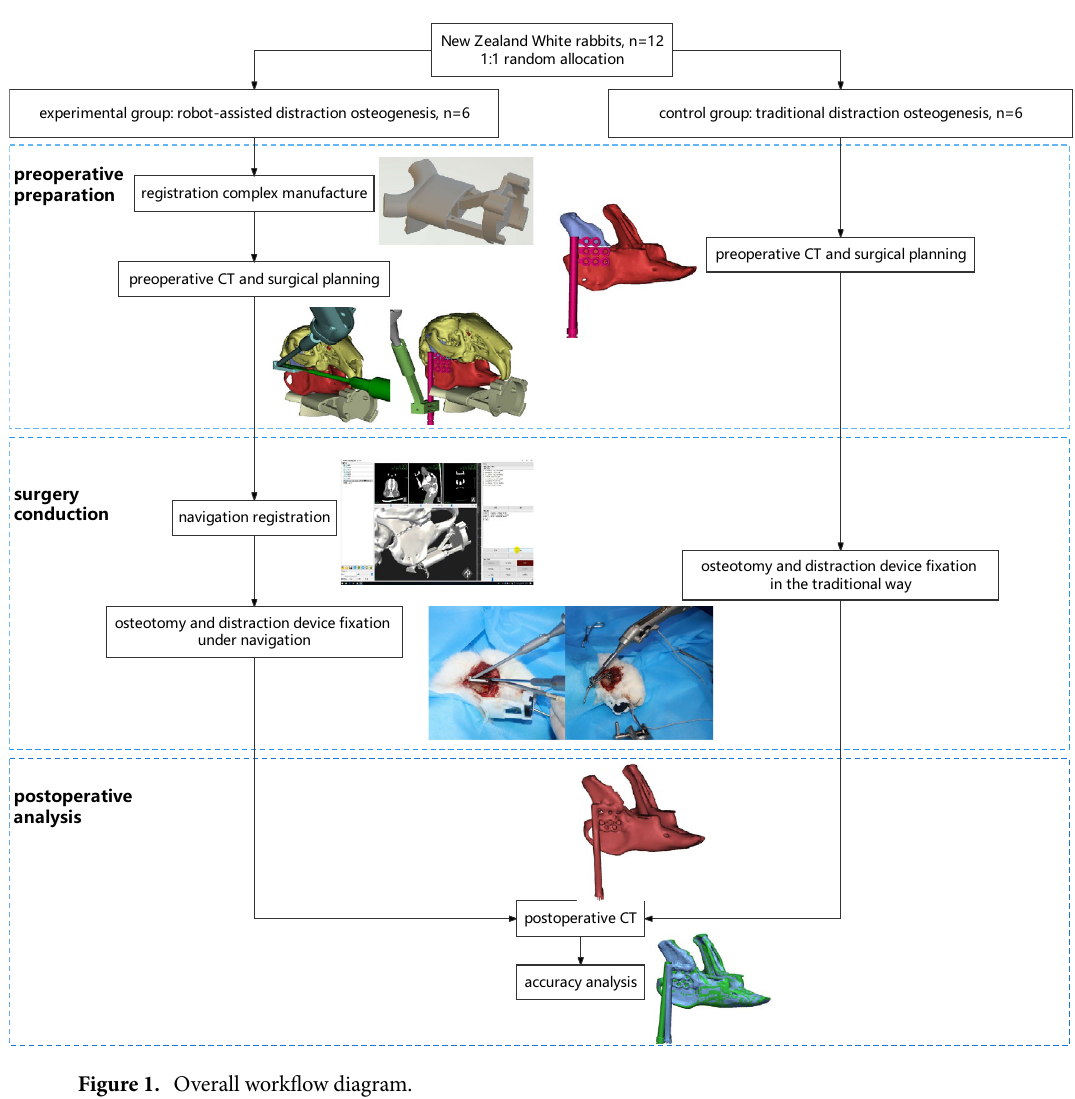
Figure 1. Overall workflow